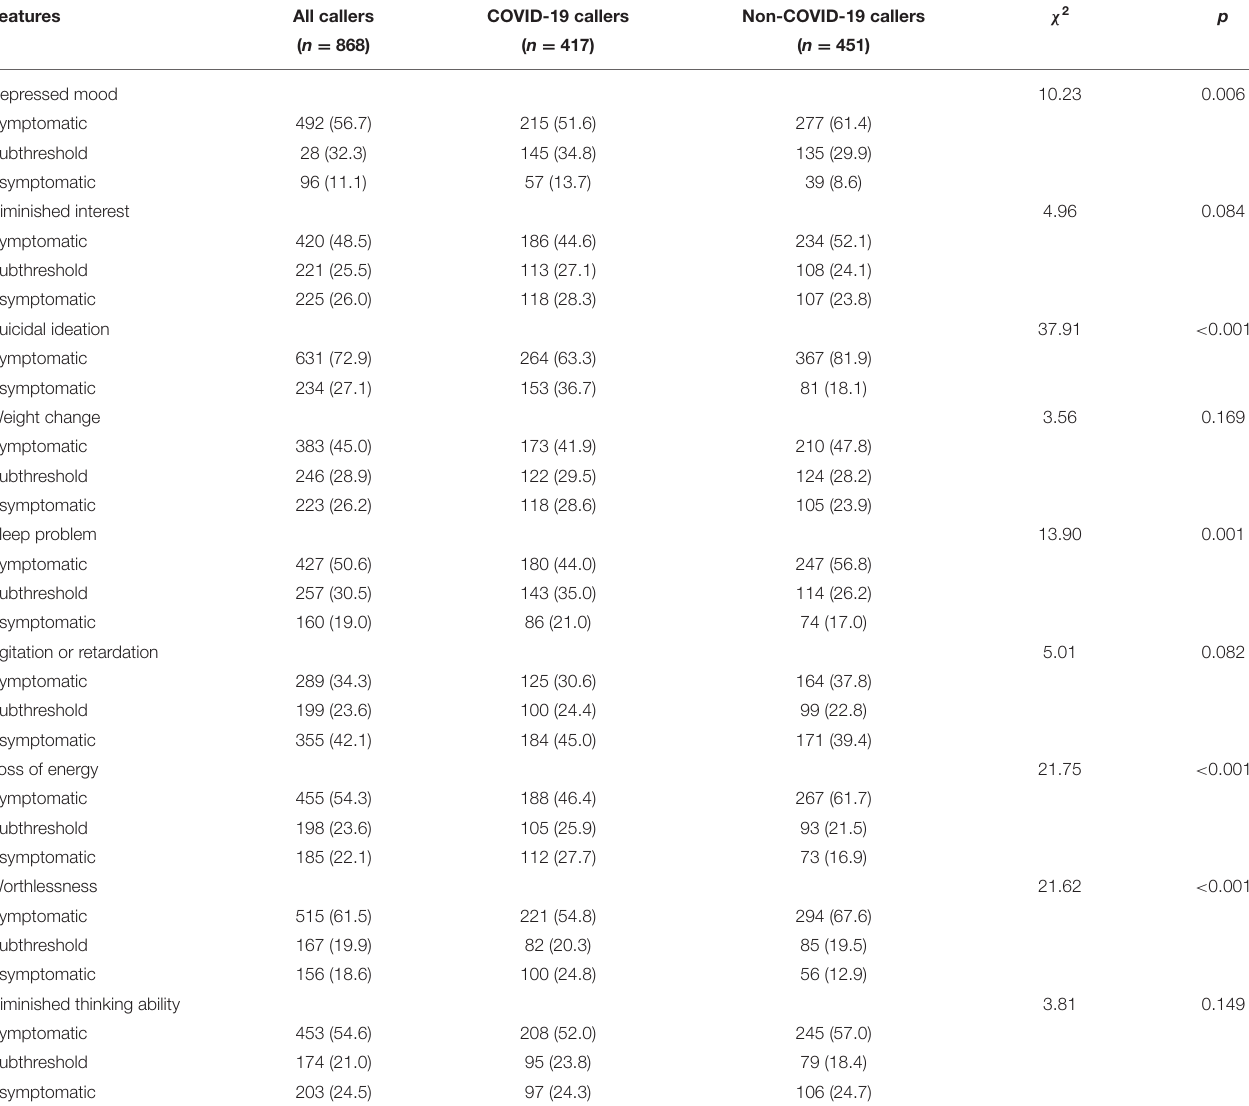
TABLE 5 | Comparison of assessed depressive symptoms between COVID-19 callers and non-COVID-19 callers [ n (%)].